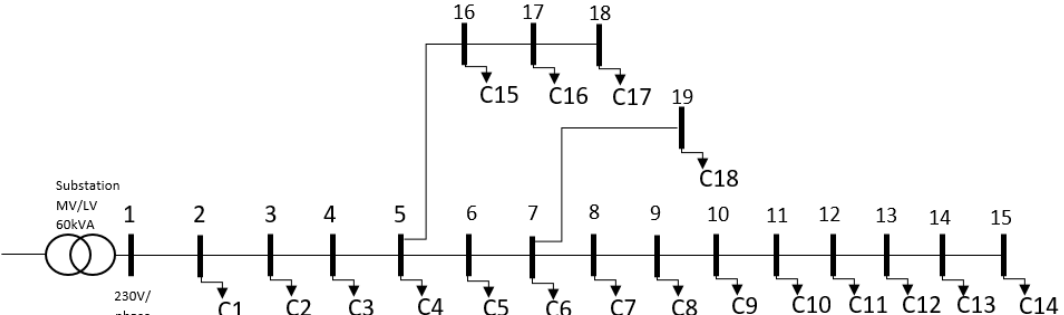
Figure 9. Topology of the monitored LV distribution network.